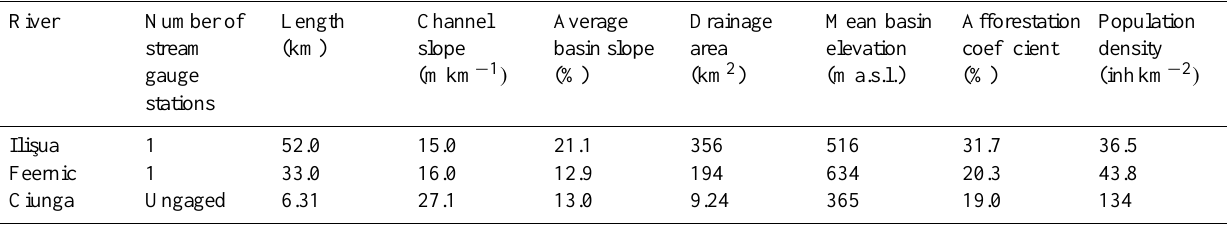
Table 2. The main characteristics of the study